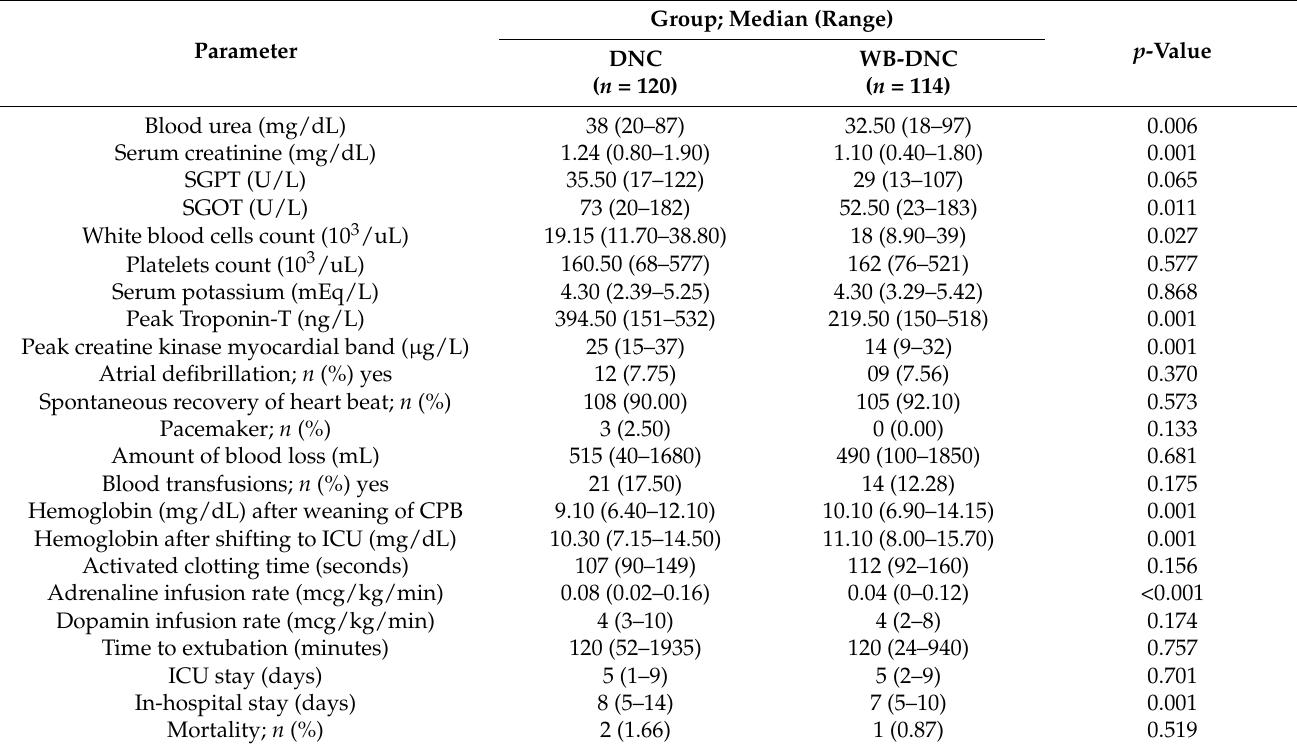
Table 3. Postoperative clinical characteristics of patients receiving Del Nido-based